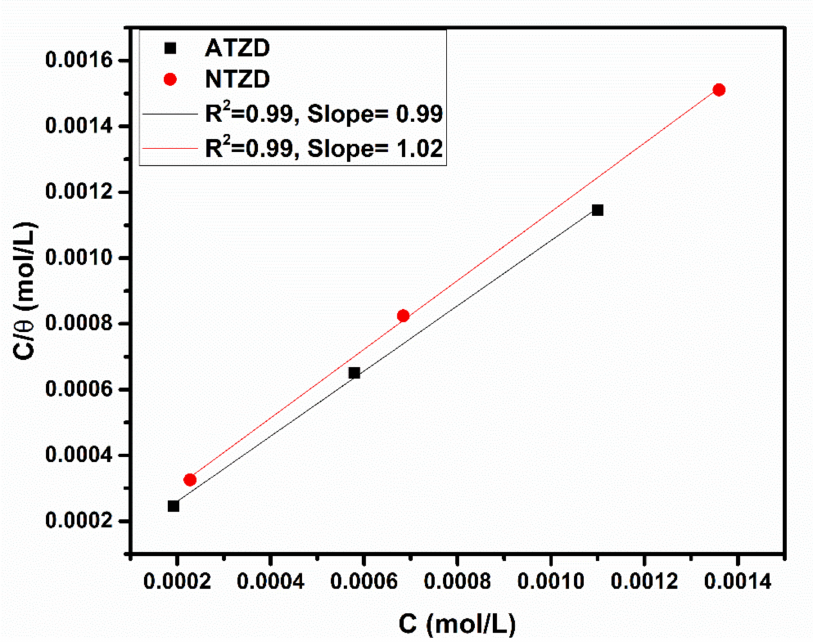
Figure 5. Langmuir’s isotherm plots for adsorption of inhibitors on copper surface in 3.5 wt.% NaCl at 298 K